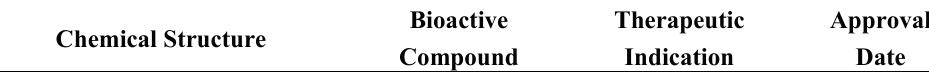
Table 1. Heterocyclic drug names approved by FDA for their anti-tumor properties (2010–2015). Heterocycles are discriminated by class, drug name, bioactive compound, therapeutic indication and approval